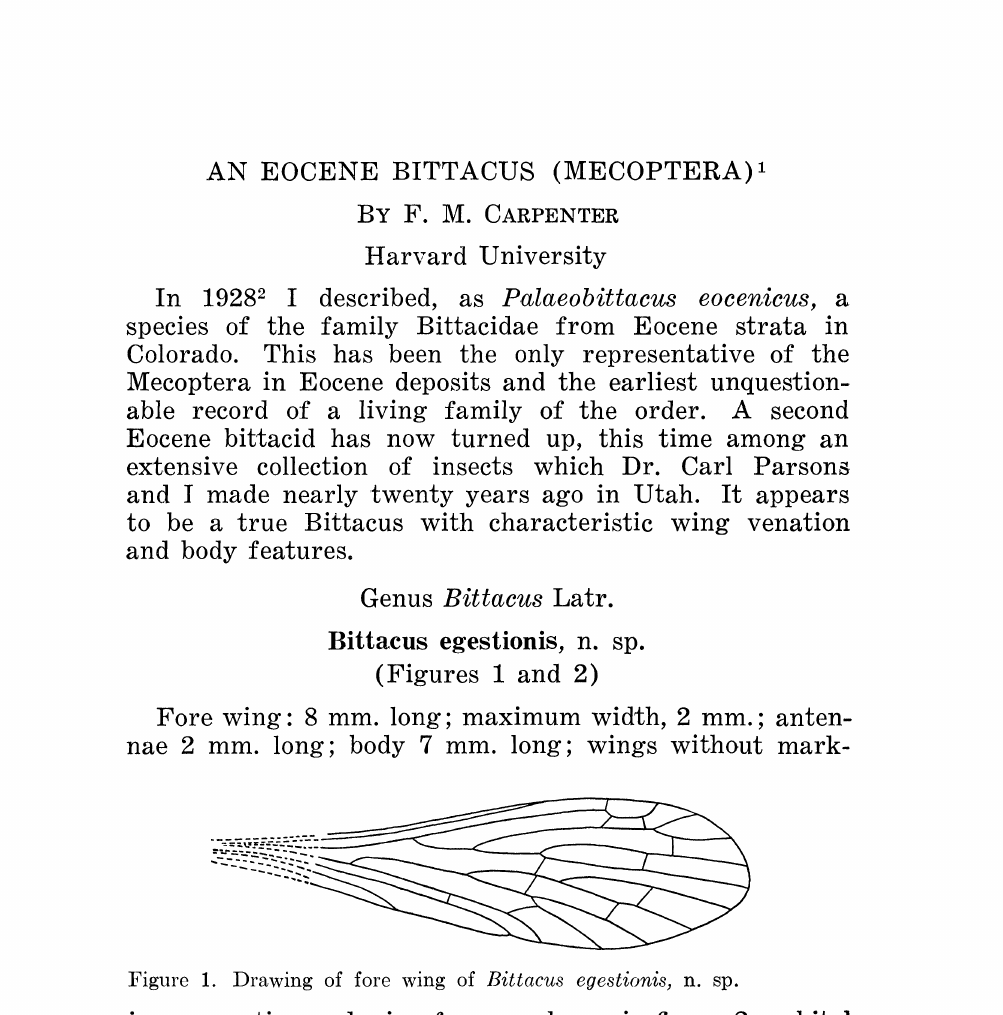
Figure 1. Drawing of fore wing of Bittacus egestionis, n. sp. ings; venation and wing form as ,shown in figure 2; cubital cross-vein below the first fork of M; two pterostigmal cross-veins apparently present; hing wings somewhat more slender than fore